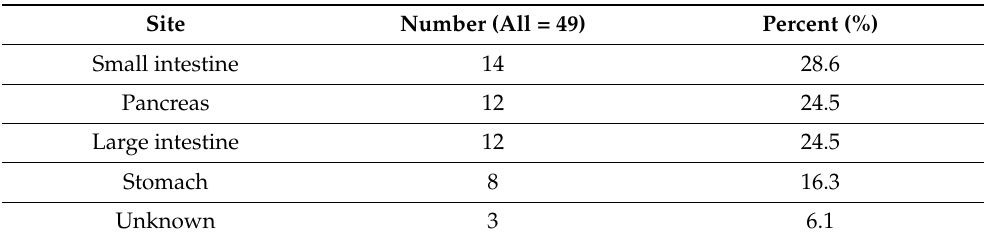
Table 1. Distribution of primary tumor locations in the group of 49 patients analyzed in the case– control part of the